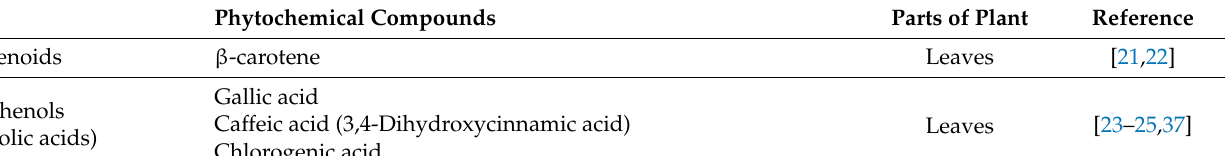
Table 3. Phytochemical compounds in Cassia alata